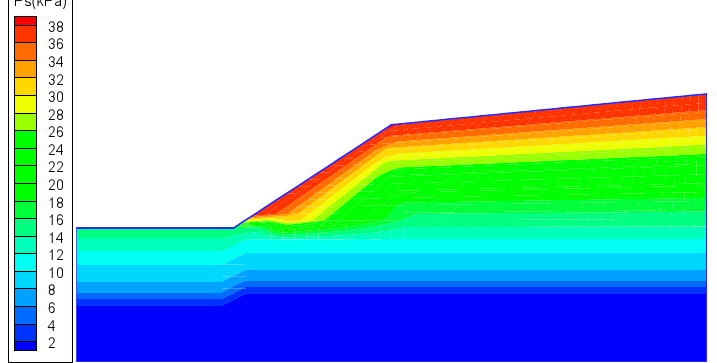
Figure 11. Contours of matric suction (unit: kPa).